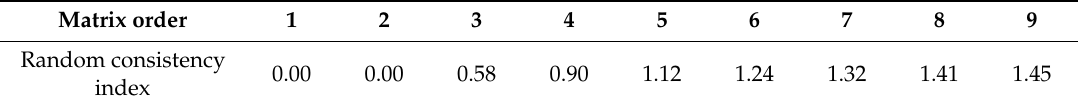
Table 9. The average consistencies of random